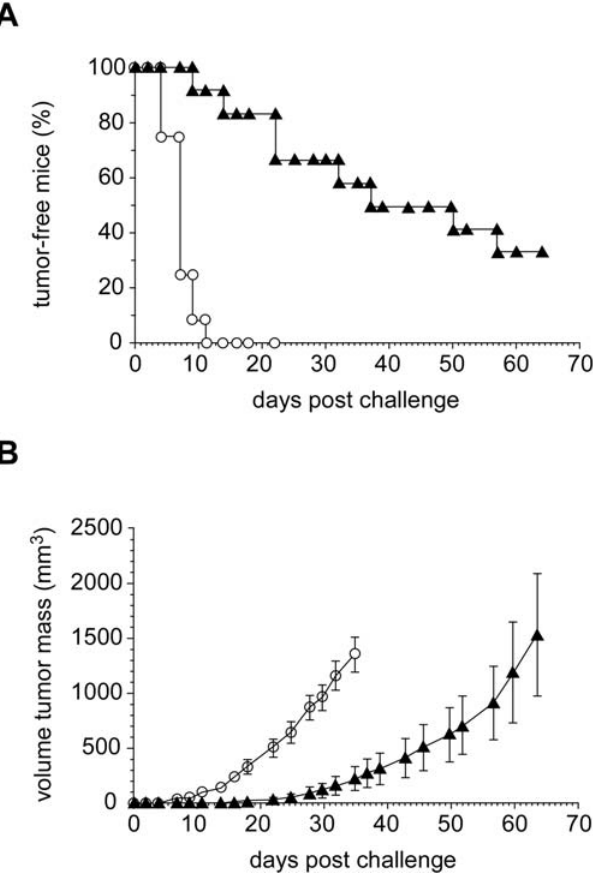
Figure 6. In vivo anti-tumoral activity of anti-TfRC Mbr-4. BALB/c nude mice were challenged with a subcutaneous injection of HCT-116 cells at day=0. A first group of mice (filled triangles; n=12) was administered with 10 i.p. injections of 0.5 mg IgG-4 three times a week starting from day=0. Mice from this group were followed up to day= 64. A second group of mice (empty circles, n= 12) was administered injections of control isotypic IgG according to the same protocol and followed up to day=35, when mice were sacrificed for ethical reasons. Both groups were monitored for tumor growth expressed as percentage of free mice (panel a) and tumor volume (b). Error bars in panel b indicate standard error of the mean (S.E.M).